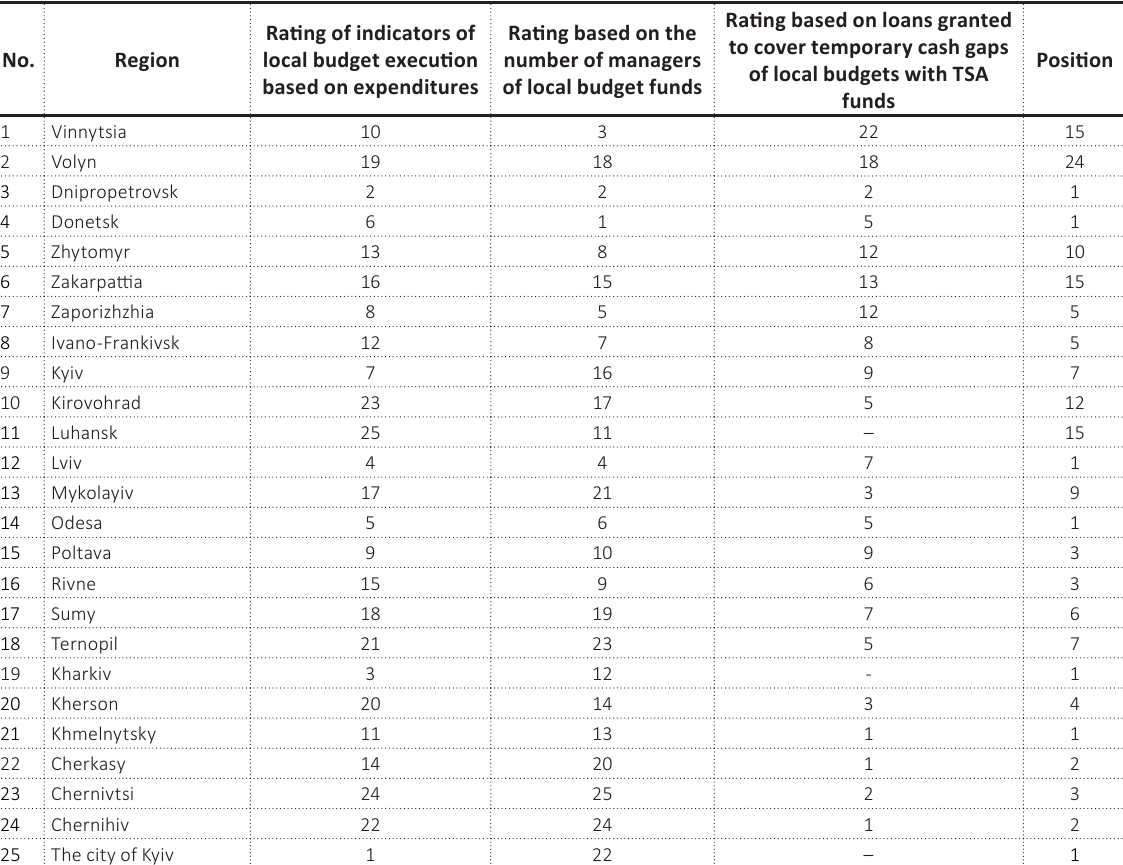
Source: Treasury of Ukraine (2022b,